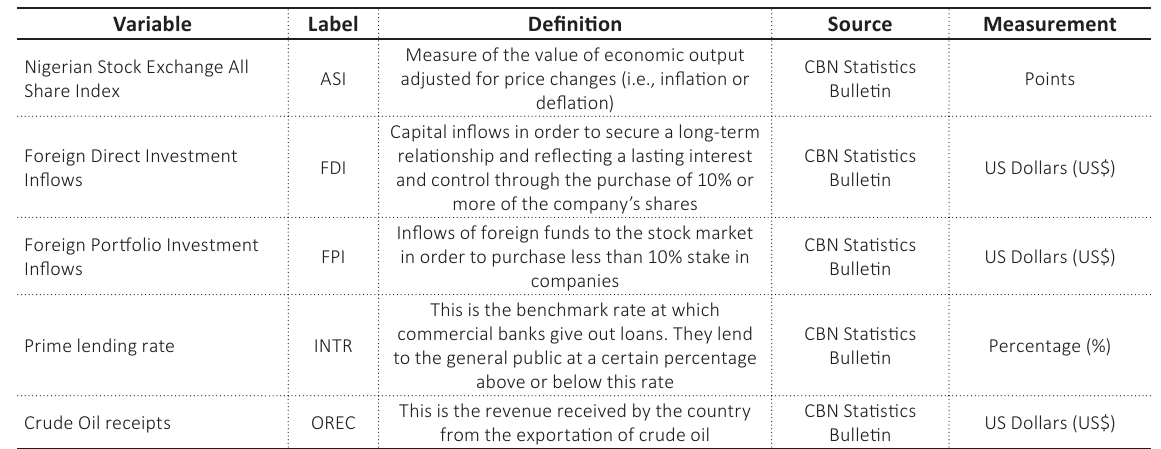
Source: Central Bank of Nigeria Statistics Database